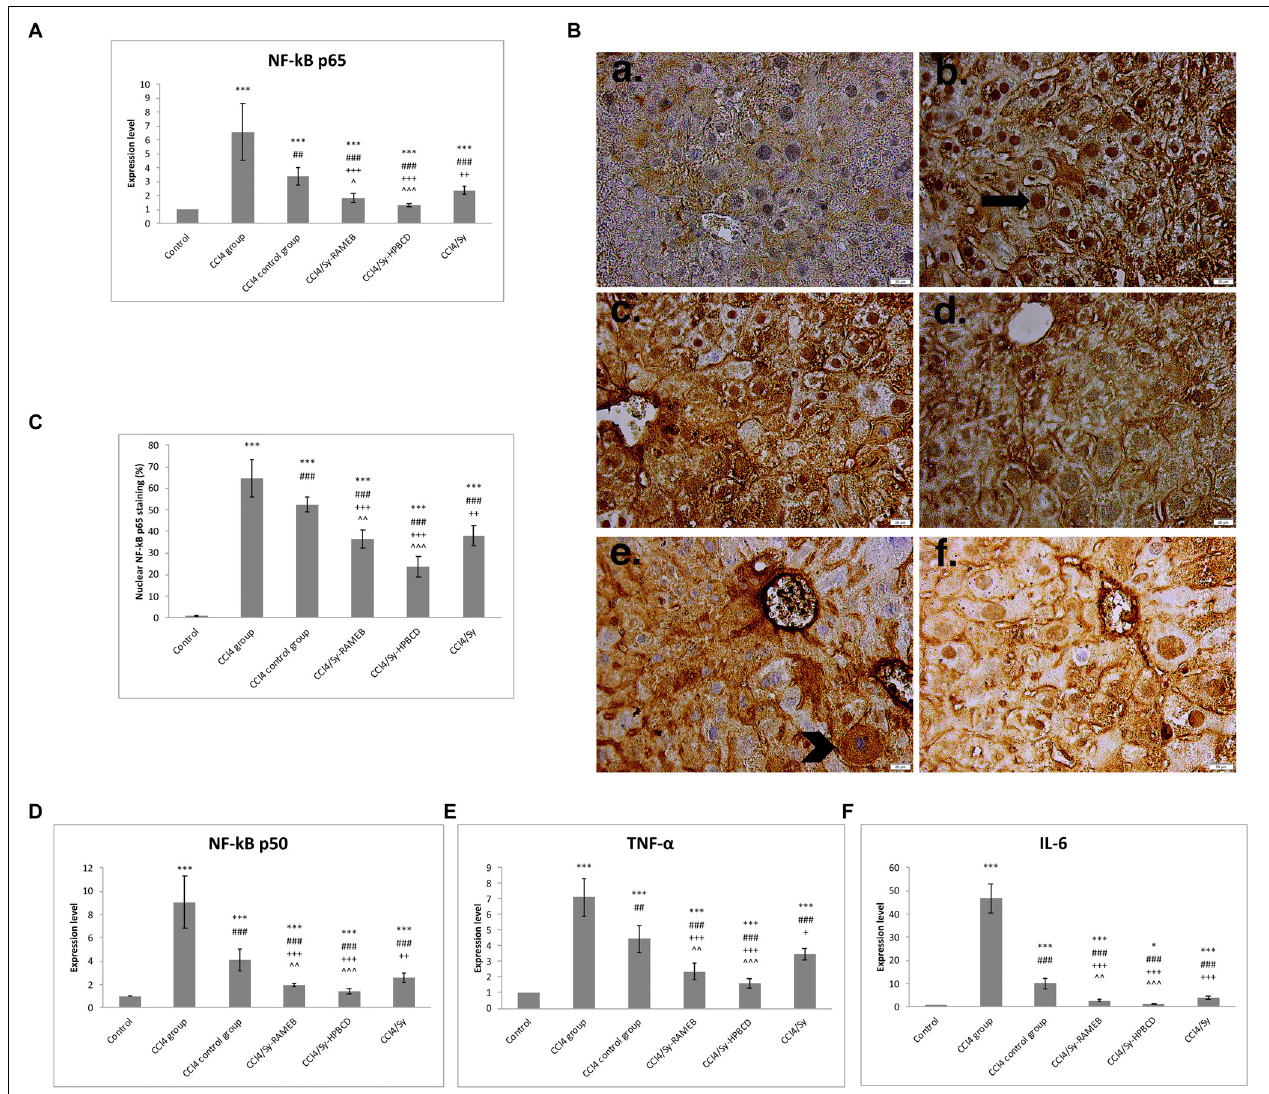
FIGURE 5 | Effects of Sy-HPBCD and Sy-RAMEB complexes on nuclear translocation of NF-kB in hepatocytes and inflammatory cytokines down-regulation in liver fibrosis. mRNA expression of NF- κ B p65 (A) , NF- κ B p50 (D) , TNF- α (E) and IL-6 (F) ; Immunohistochemical staining of NF- κ B p65 (B) ; arrow – hepatocytes with only nuclear NF- κ B p50 staining; arrowhead – hepatocytes with only cytoplasmic NF- κ B p50 staining. The percentage of hepatocytes with only nuclear NF-kB p65 staining out of the total number of hepatocytes was calculated (C) . Data are expressed as the arithmetic mean ± standard deviation (SD) of five mice per group; ∗∗∗ p < 0.001 compared to control; ### p < 0.001 compared to CCl +++ p < 0.001 compared to CCl 4 group; ## p < 0.01 compared to CCl 4 group; 4 control group; ++ p < 0.01 compared to CCl + p < 0.05 compared to CCl 4 control group; ˆˆ p < 0.01 compared to CCl 4 /Sy group; ˆˆˆ p < 0.001 compared to CCl 4 /Sy group. 4 group; ∗ p < 0.05 compared to